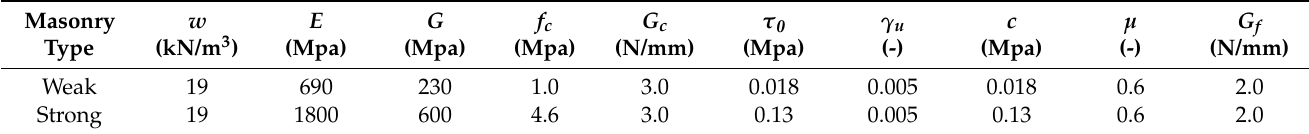
Table 1. Material parameters for the arch used in the validation.